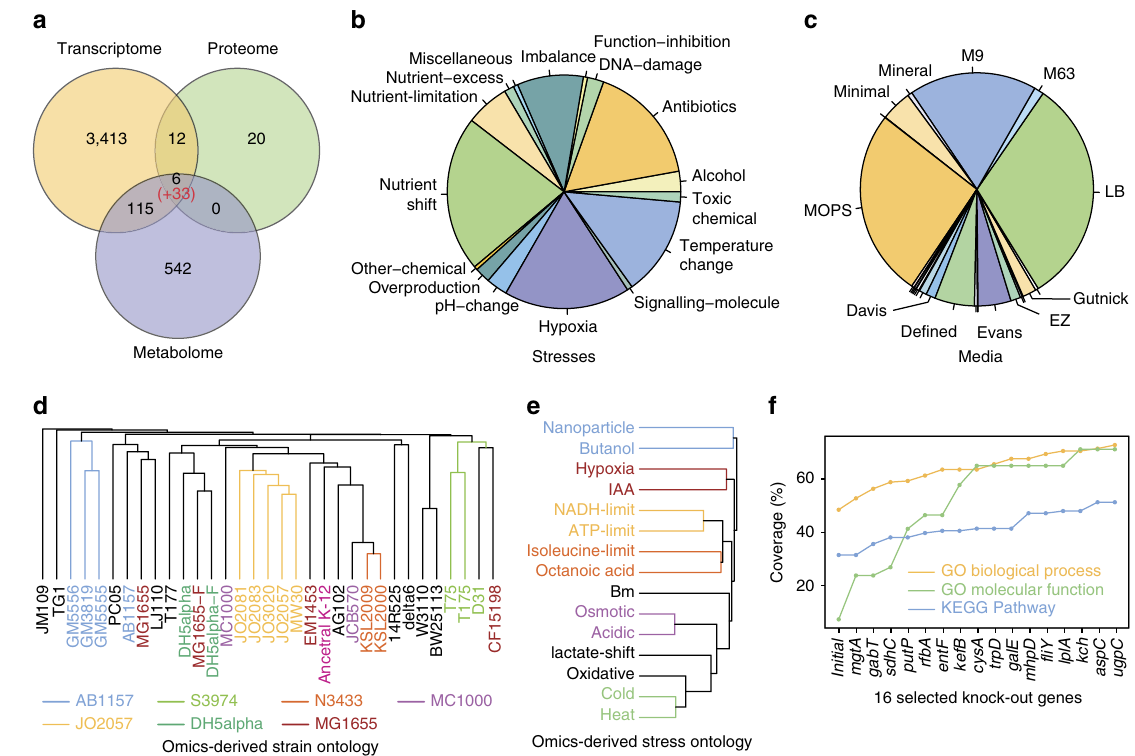
Figure 4 | Analysis of the Ecomics compendium. ( a ) Number of profiles across the transcriptome, proteome and metabolome layers. The number in parentheses represents the profiles targeted for core metabolism 62 . ( b ) Stress distribution in Ecomics. The 52 stresses used in the compendium are grouped into 16 categories. Imbalance refers to the imbalance between production and consumption of reactive species (for example, oxidative, nitrosative). Alcohol represents exposures in alcoholic compounds such as butanol or ethanol. Overproduction refers to the overexpression of macromolecules such as fatty-acid or recombinant protein. Function-inhibition refers to the inhibition of cellular function such as lipid synthesis or peptidoglycan. ( c ) Media distribution in Ecomics. The 112 media used in the compendium are grouped into 25 basic categories (14 displayed; K, modified complex, BHI, ACSH, TSB, TB, SynH, TPM2, dYT, phosphate, DMA, DMEM, GMM, GGM are not displayed). ( d ) Strain ontology based on omics profiles. Only transcriptional profiles in LB medium were used. Colour represents strain derivatives. ( e ) Stress ontology based on omics profiles. Only transcriptional profiles in M9/MOPS media and without stress or genetic perturbation were used. Colour represents common biological processes that are enriched in each stress pair: signal transduction (cyan); central metabolism (red), transport (yellow); cell division (purple); ribosome formation (green). ( f ) GO coverage enrichment. 16 gene knock-out experiments were iteratively selected based on the number of unrepresented GO terms that were perturbed. Coverage on the y axis is the percentage of functional terms represented in the compendium. The ‘initial’ point on the x axis indicates the Ecomics GO coverage before